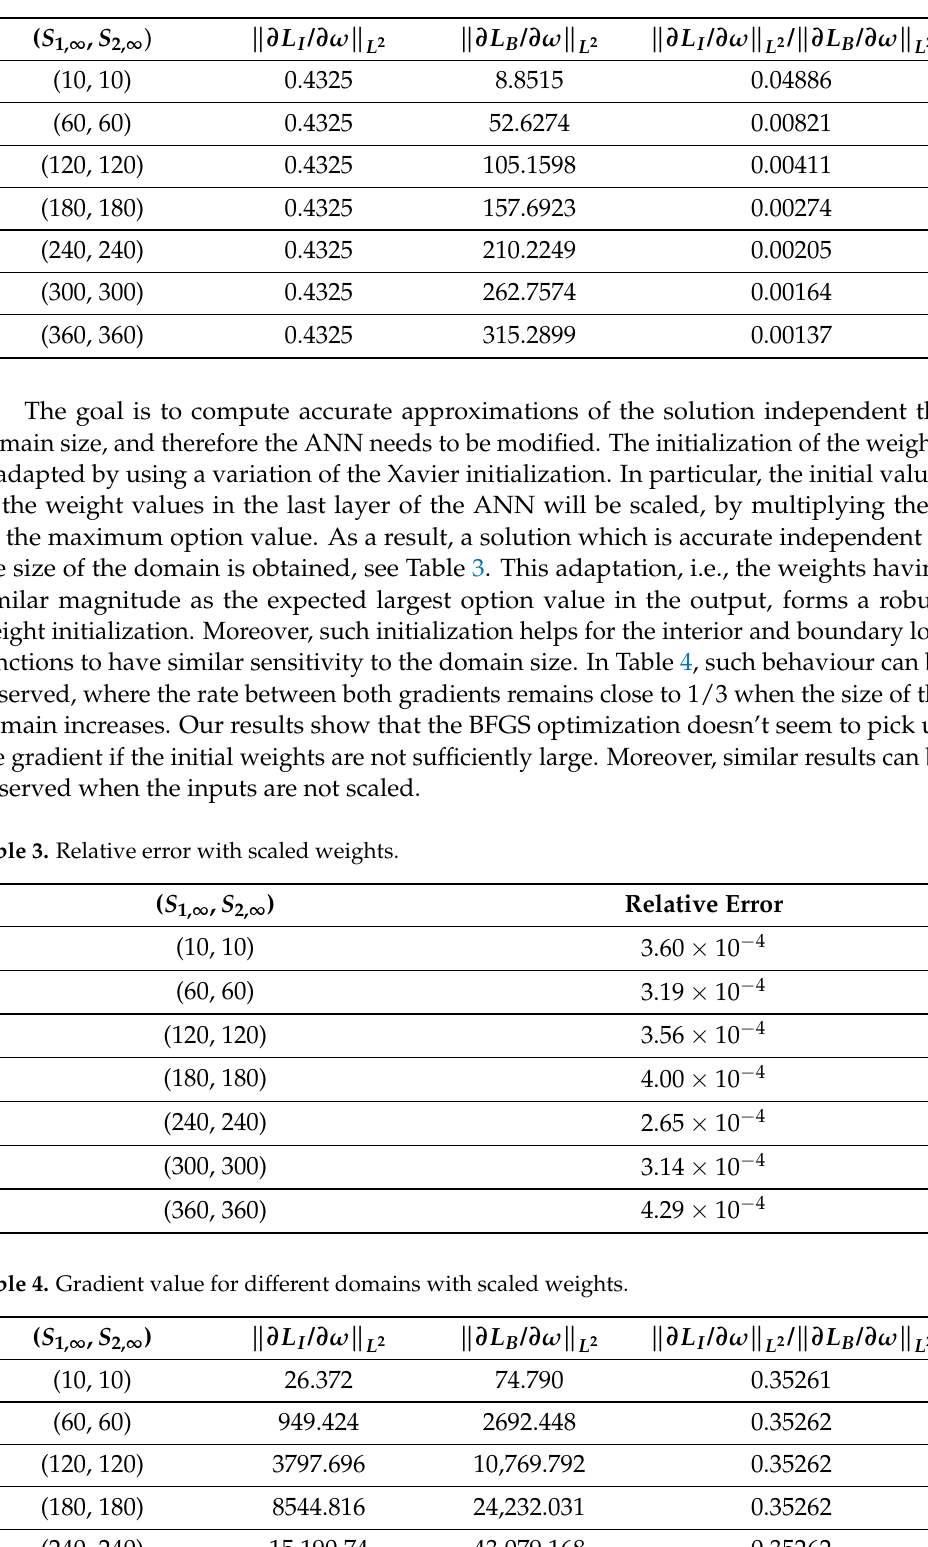
Table 2. Gradient values for different domain sizes with standard weights.